Question: Draft a figure caption describing what is shown.
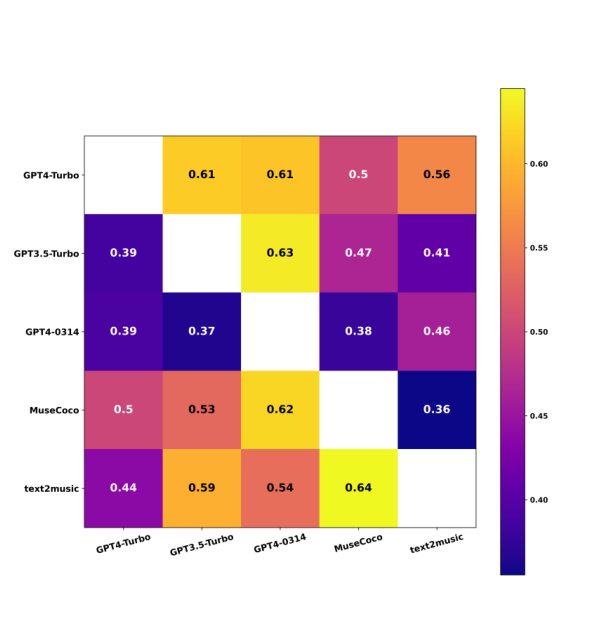
Answer: Result from listening test comparing multi- agent baselines with GPT-4-Turbo, GPT-4-0314, GPT- 3.5-Turbo checkpoints, MuseCoco and text2music Base- lines. Each row indicates the fraction of listeners’ pref- erence for the indicated baseline over other baselines. In this case, the strongest multi-agent baseline with GPT-4- Turbo checkpoints outperformed text2music, and received the same score as MuseCoco.